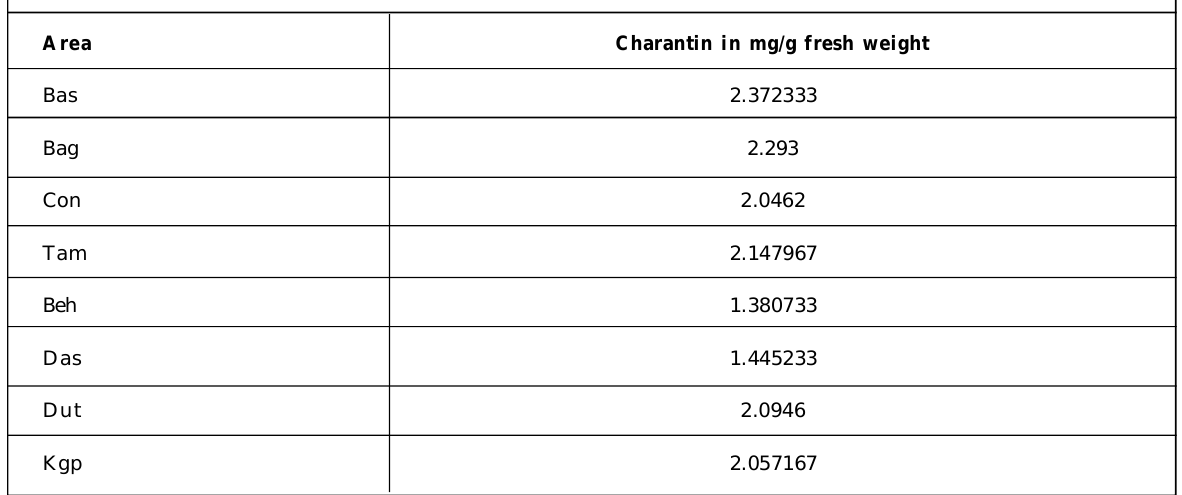
Table 15: Charantin content across different cultivation